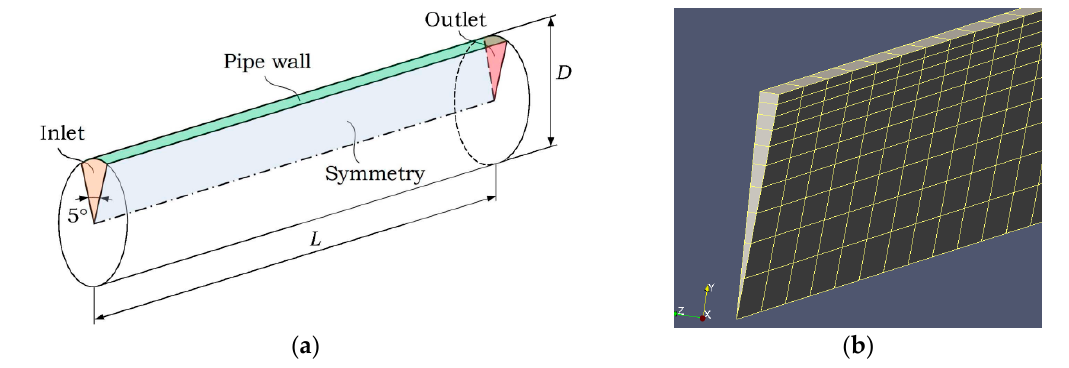
Figure 2. Geometry and mesh modeling: ( a ) 2-D axisymmetric domain flow; ( b ) Snapshot of the 2-D numerical mesh.